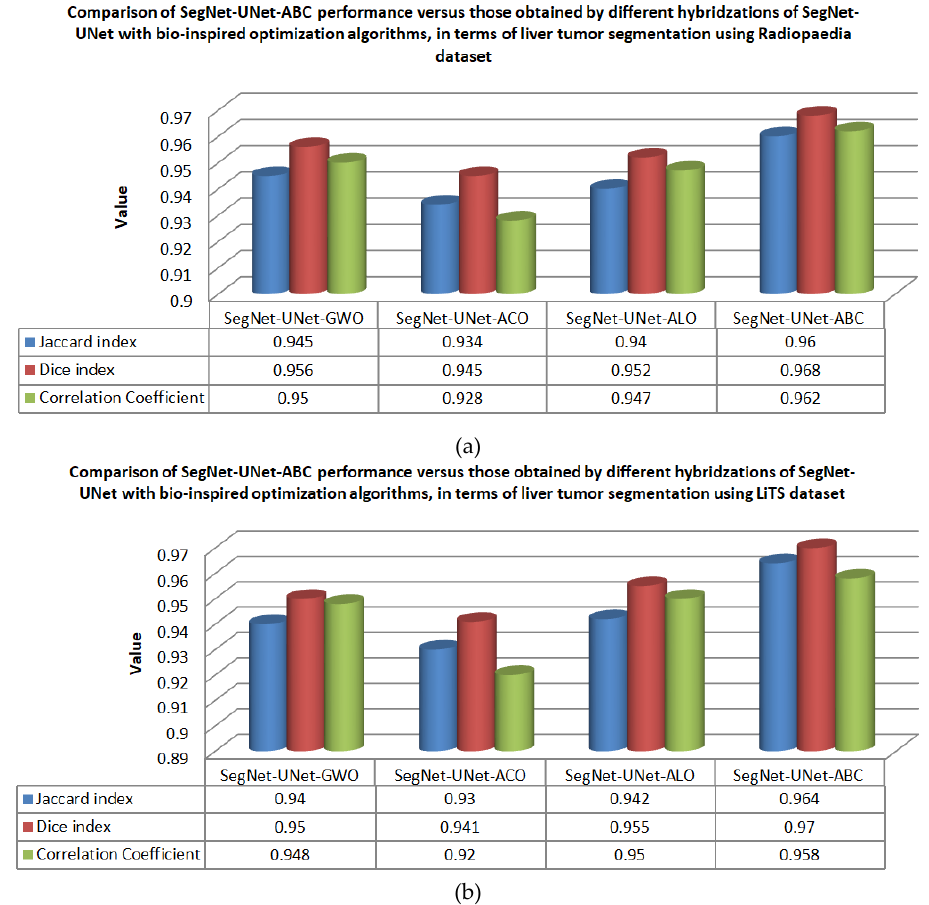
Figure 11. Comparisons of the segmentation performance using SegNet-UNet-ABC, SegNet-UNet-GWO, SegNet-UNet-ALO, and SegNet-UNet-ACO, over the datasets ( a ) Radiopaedia and ( b ) LiTS.